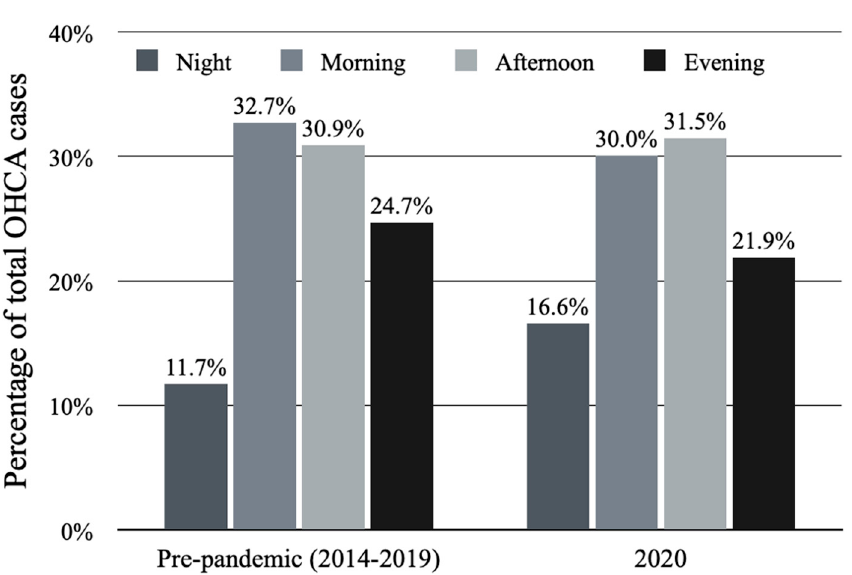
Figure 2. Circadian distribution of out-of-hospital cardiac arrest (OHCA) occurrence in 6 h intervals within 24 h in year 2020 ( p < 0.001) and during 2014–2019 pre-pandemic period ( p < 0.001). The distribution of OHCA occurrence in days of the week is presented in Figure 3. The lowest number of OHCA cases was observed on Monday (10.8%) with a gradually increasing number in the subsequent days reaching the highest value on Friday (16.8%). variability did not reach statistical significance ( p = 0.268).